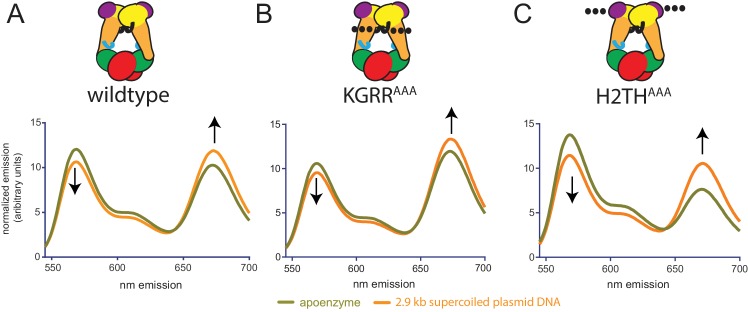
Conformational response of H2THAAA and KGRRAAA constructs on different substrates as determined by FRET in the absence of nucleotide.Comparison of the fluorescence emission spectra produced by 530 nm excitation of Alexa555/Alexa647-labeled (A) TopoVIcyslite-155C, (B) KGRRAAA, cyslite-155C and (C) H2THAAA, cyslite-155C alone and on supercoiled DNA, as related to Figure 6D. For all three constructs, supercoiled DNA modulates the conformation of the Topo6B ATPase domain in the absence of nucleotide as assessed by FRET. Spectral emission was normalized by total emission from 545 nm to 700 nm.